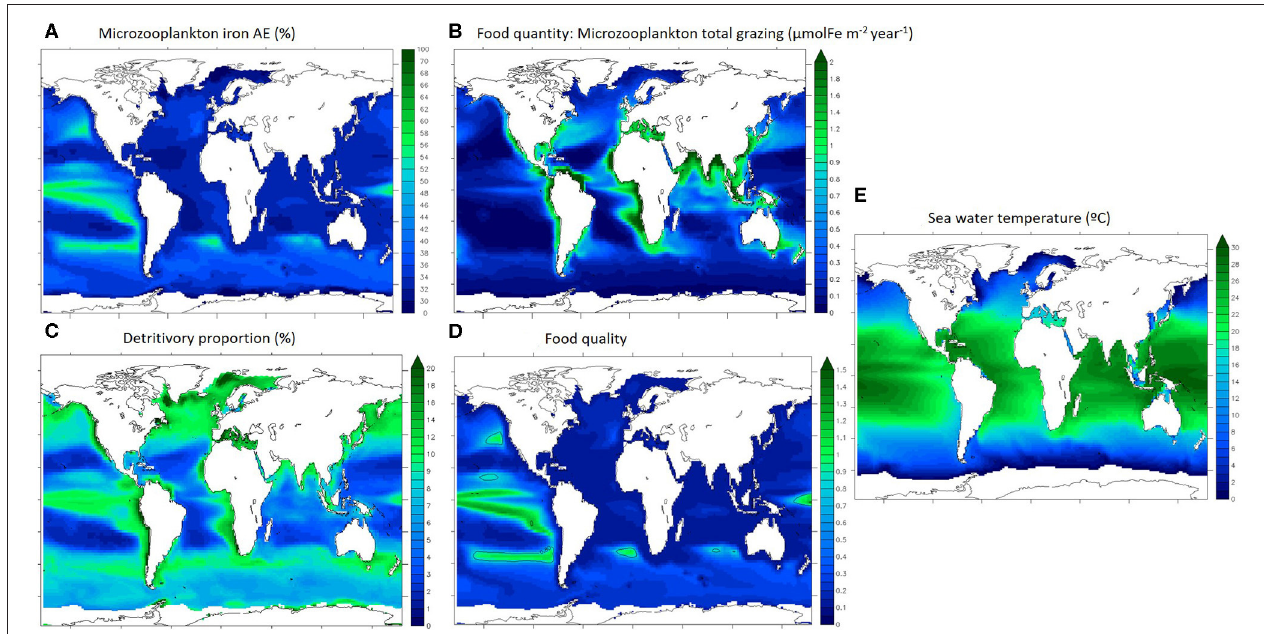
FIGURE 3 | Drivers of microzooplankton recycling in the upper 100 m. (A) iron assimilation efficiency, (B) microzooplankton integrated grazing, (C) proportion of detrivtivory in microzooplankton diet, (D) food quality index, (E) sea water temperature. Ice covered regions (defined as grid points with an annually averaged ice cover > 50%) are masked out.